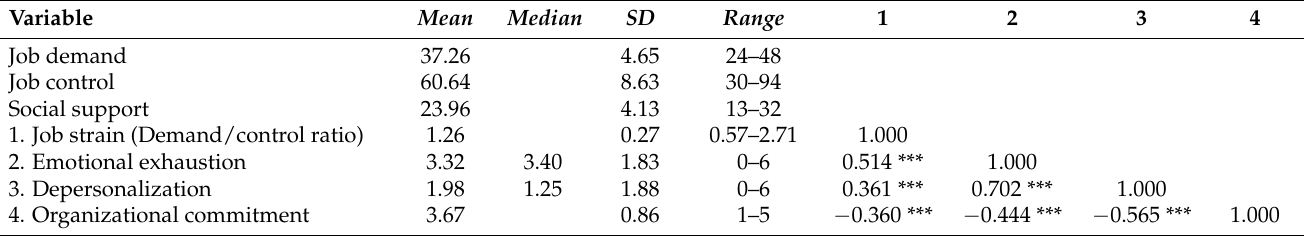
Table 1. Descriptions and correlations of the main variables ( n =